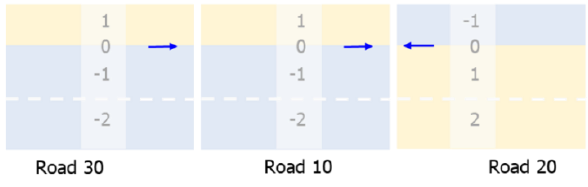
Figure 4. Possible connections between two connecting roads Figure 2. Lane linkage in OpenDRIVE standard (ASAM e.V., 2022)